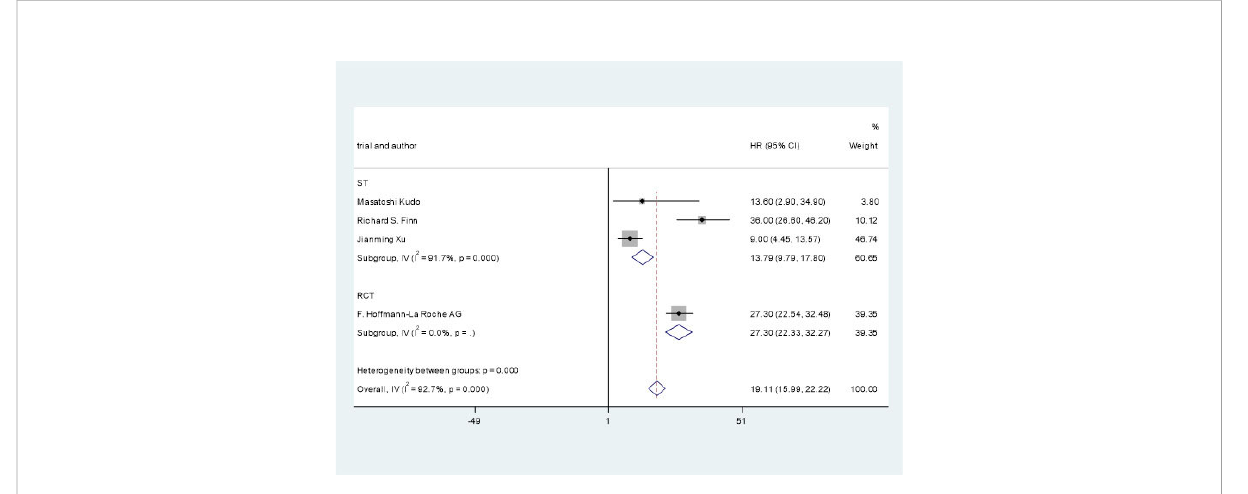
FIGURE 6 Pooled analysis of ORR in patients with HCC treated with immune checkpoint inhibitors combined with antiangiogenic